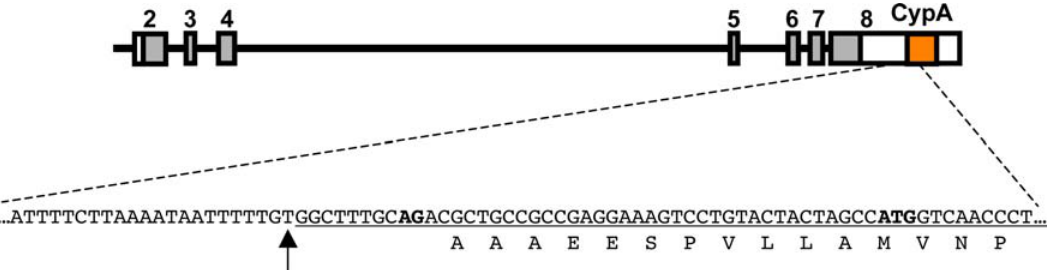
Figure 4. 5 9 junction of the inserted CypA pseudogene. The first 56 nucleotides of the insertion are underlined. The first nucleotide of the inserted sequence is indicated with an arrow, and occurs just after nucleotide position 671,500 of rhesus macaque chromosome 14 (accession # NW_001100384, based on M. mulatta reference assembly Mmu1 01212), in or near the 3 9 UTR of TRIM5 . The 3 9 ss AG dinucleotide and the first methionine codon in the CypA pseudogene are in boldface. Splicing from the end of TRIM5 exon-6 occurs 35 bases upstream of the AUG, but maintains a continuous open reading frame.